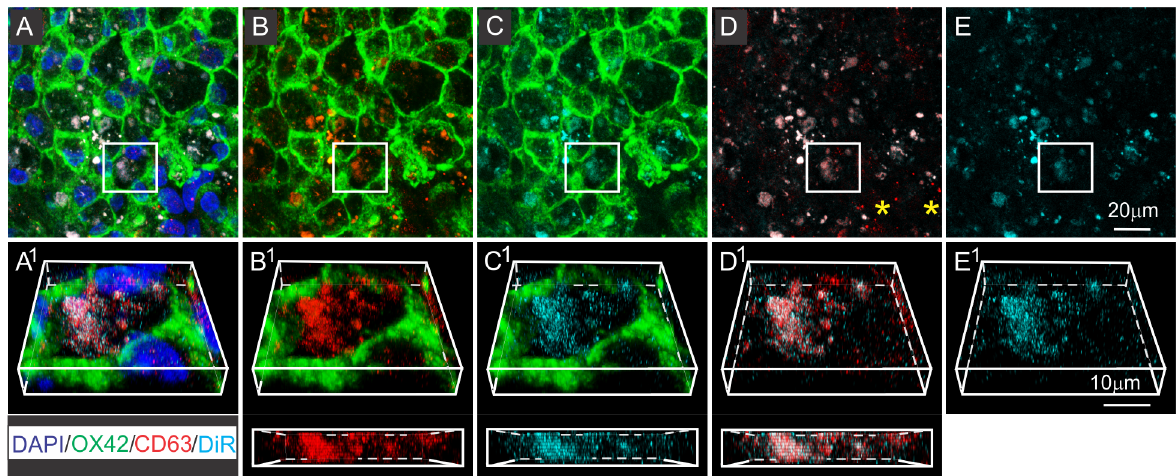
Fig 4. DiR hotspots in DiR-MSC exos infused animals co-localize with CD63 exosome marker. A-E: Representative region of a contused spinal cord 24 hours after DiR MSC exos (cyan) infusion stained with antibodies directed against OX42 (green) and the tetraspanin CD63 (red), and counterstained with DAPI (blue) (A) or DiR fluorescence only (cyan). Images show all wavelengths (A), OX42 & CD63 (B), OX42 & DiR (C), CD63 & DiR (D), DiR only (E). A 1 -E 1 : enlarged and rotated sections of boxed regions shown in A-E. Images below B 1 , C 1 , and D 1 respectively show full 90 degree rotations of boxed regions showing CD63, DiR, and CD63 & DiR fluorescence. Note the strong co-localization between DiR fluorescence and CD63 staining. Scale bar in E = 20 μ m E 1 = 10 μ m.